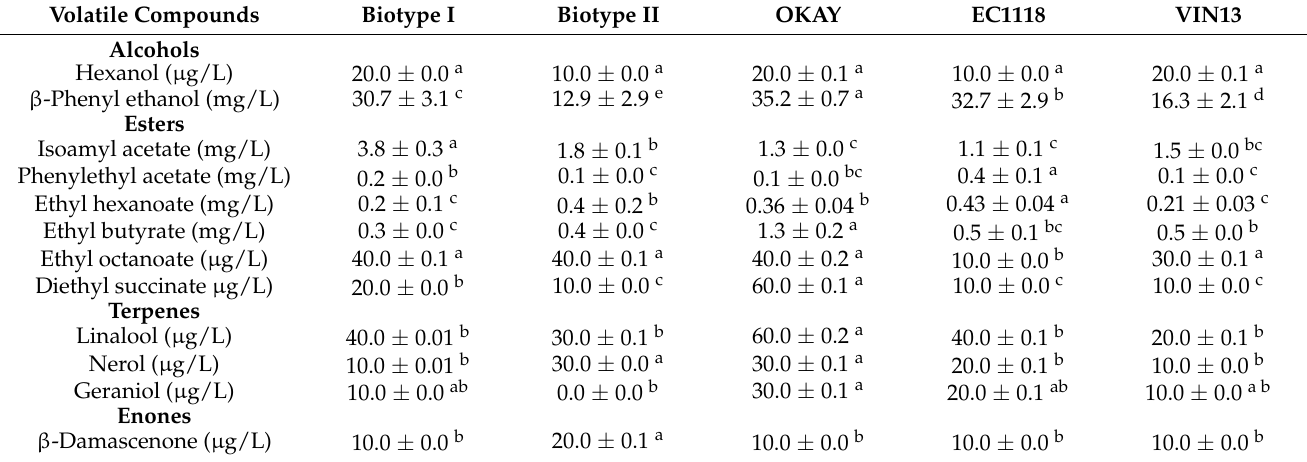
Table 6. Main volatile compounds of wines carried out at 22 ◦ C. Data are means ± standard deviations, and those with different superscript letters ( a–d ) within each column are significantly different, according to Duncan’s tests ( p -value <